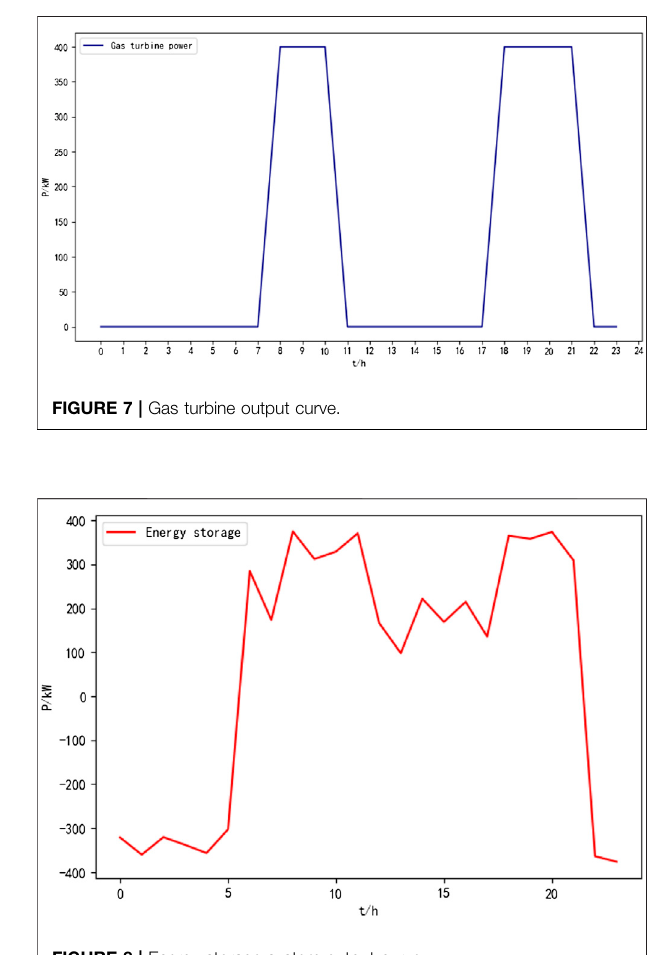
FIGURE 8 | Energy storage system output